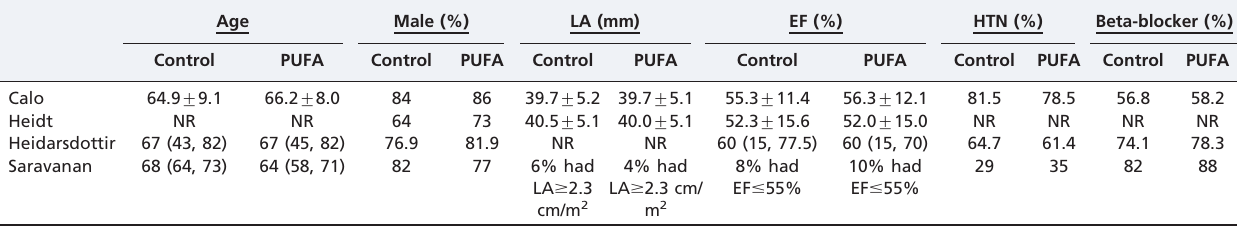
Table 2 - Baseline